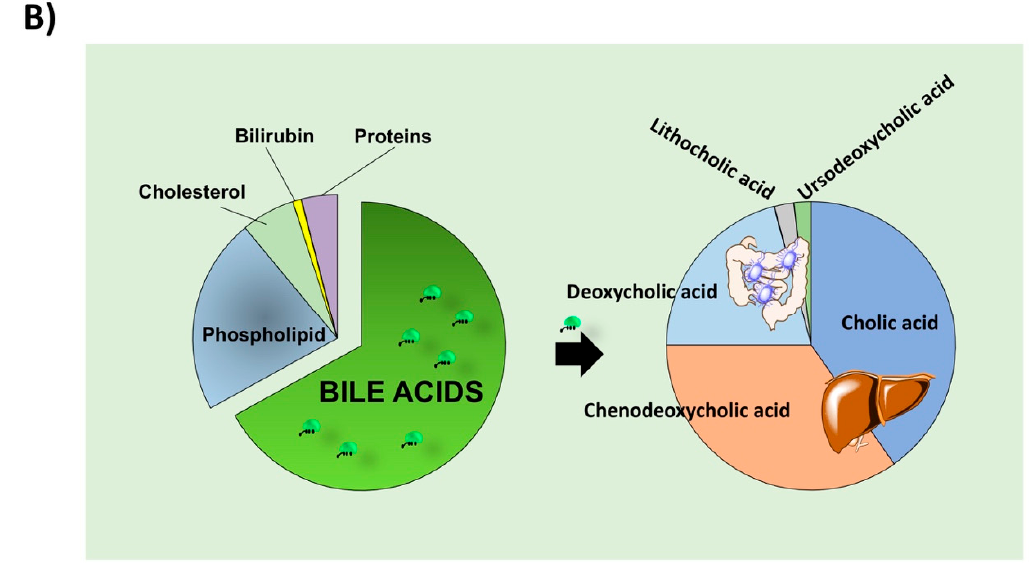
Figure 1. ( A ) Sites of synthesis and metabolism of primary, secondary, and tertiary bile acids (BA) in humans. Cholesterol in the liver undergoes modification of the sterol ring, oxidation, and shortening of the side chain. The classical “neutral” pathway involves the cytochrome P450 enzyme, cholesterol 7 α -hydroxylase (CYP7A1), and contributes to about 75–90% of total BA pool consisting of cholic acid (CA) and chenodeoxycholic acid (CDCA). The alternative “acidic” pathway is mitochondrial and contributes to 10–25% of total BA pool [1,7] with the rate-limiting enzyme cholesterol 27 α -hydroxylase (CYP27A1) and then 25-hydroxycholesterol 7-alpha-hydroxylase (CYP7B1) [8,9] to produce CDCA. BA in the liver undergo conjugation with amino acids, glycine or taurine (ratio of 3:1), via N-acyl amidation at carbon 24 of the aliphatic side chain [10] and active biliary secretion. In the colon the resident bacteria interact with primary BA by dehydroxylation, dehydrogenation, 7 α -dehydroxylation and epimerization. By this pathway, secondary BA are the dihydroxy deoxycholic acid (DCA) and the monohydroxy lithocholic acid (LCA). The 7 α -dehydrogenation of CDCA forms the dihydroxy 7 α -oxo-LCA which is metabolized to the “tertiary” 7 β -epimer, the dihydroxy ursodeoxycholic acid (UDCA). In the liver, a small amount of LCA is quickly transformed to sulphonated form (S-LCA). In the terminal ileum, BA uptake is about 80% by active transport within the enterocytes. In the colon, secondary BA undergo passive di ff usion and reabsorption (~15%) [11] into the portal tract. ( B ) Relative composition of hepatic and gallbladder bile in healthy humans. Left: major solutes; right: contribution of individual bile acids. Changing the composition of the BA pool could ultimately influence the signalling ability of BA on nuclear receptors such as farnesoid X receptor (FXR), pregnane X receptor (PXR), vitamin D receptor (VDR), as well as the membrane-associated receptors G protein-coupled bile acid receptor 1 (GPBAR-1) and sphingosine-1-phosphate receptor 2 (S1PR2) [12–14] .